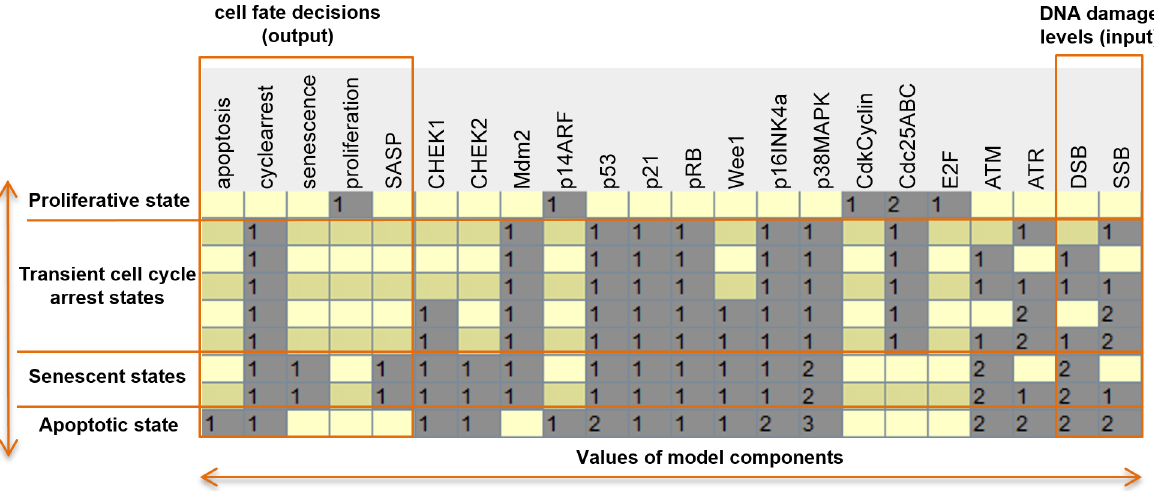
Fig 2. Stable states of the model for astrocyte wild-type case. The two right-most columns list in each line the 9 possible combinations of SSB and DSB. For each line there is a unique stable state characterized by the value of the components and the cell fate is determined by the output components in the 5 left-most columns. Numbers stand for variables state values and empty spaces correspond to state value